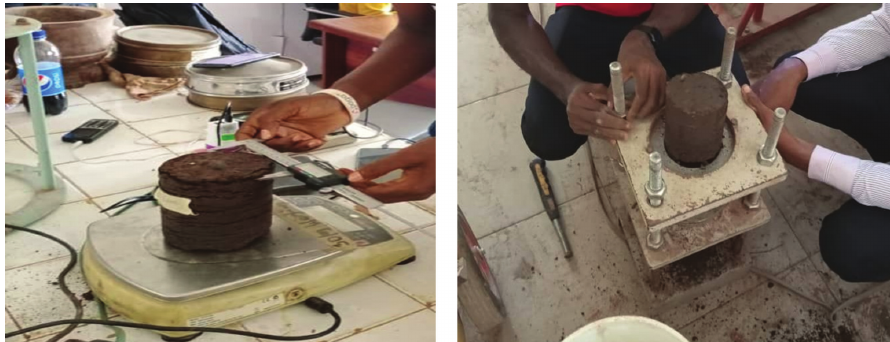
Figure 7: HSDA-treated specimen extrusion and measurement.